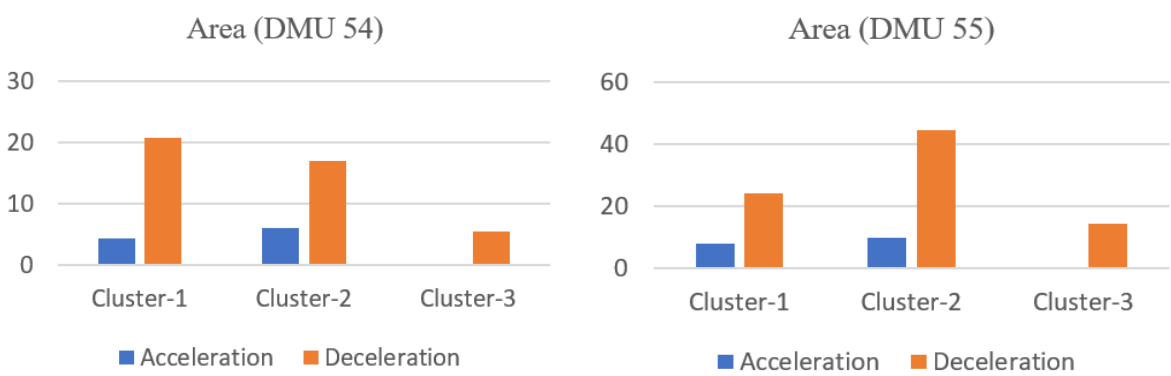
Figure 4. The area accumulation with respect to acceleration and deceleration for DMUs 54 and 55.